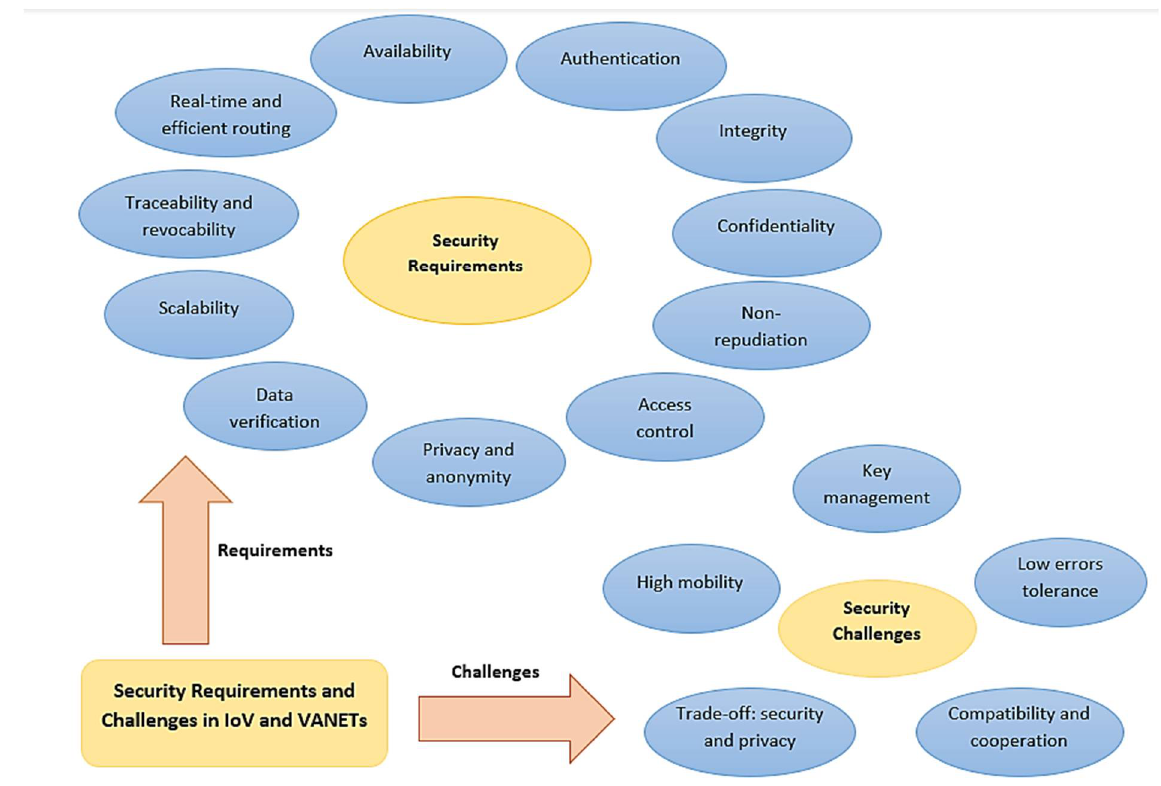
Figure 3. The security requirements and challenges in IoV and VANETs platforms.